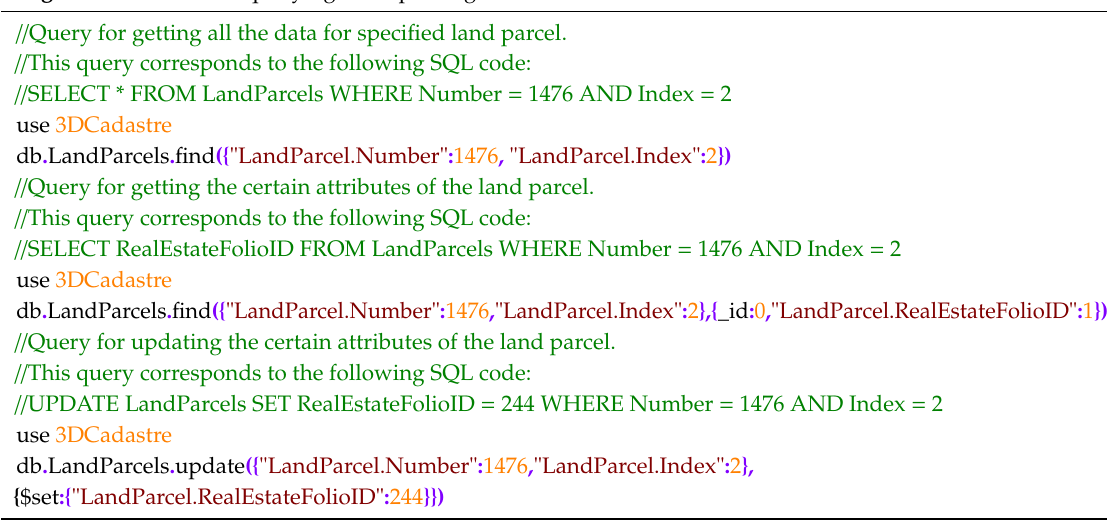
Algorithm 2: Code for querying and updating the data in the database // Query for getting all the data for specified land